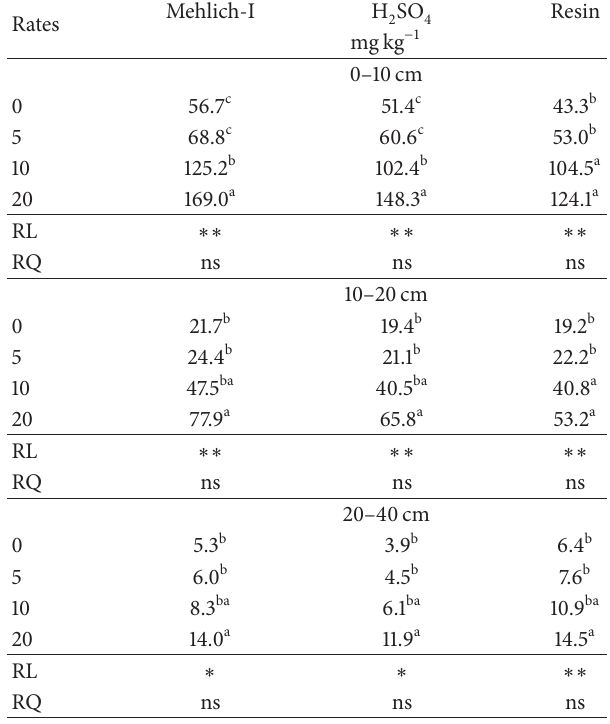
SO , and Table 3: Mean extracted phosphorus by Mehlich-I, H 2 4 resin from samples collected at three depths from soils treated with varying rates of sewage sludge, in the long-term experiment ( 𝑛 = 4